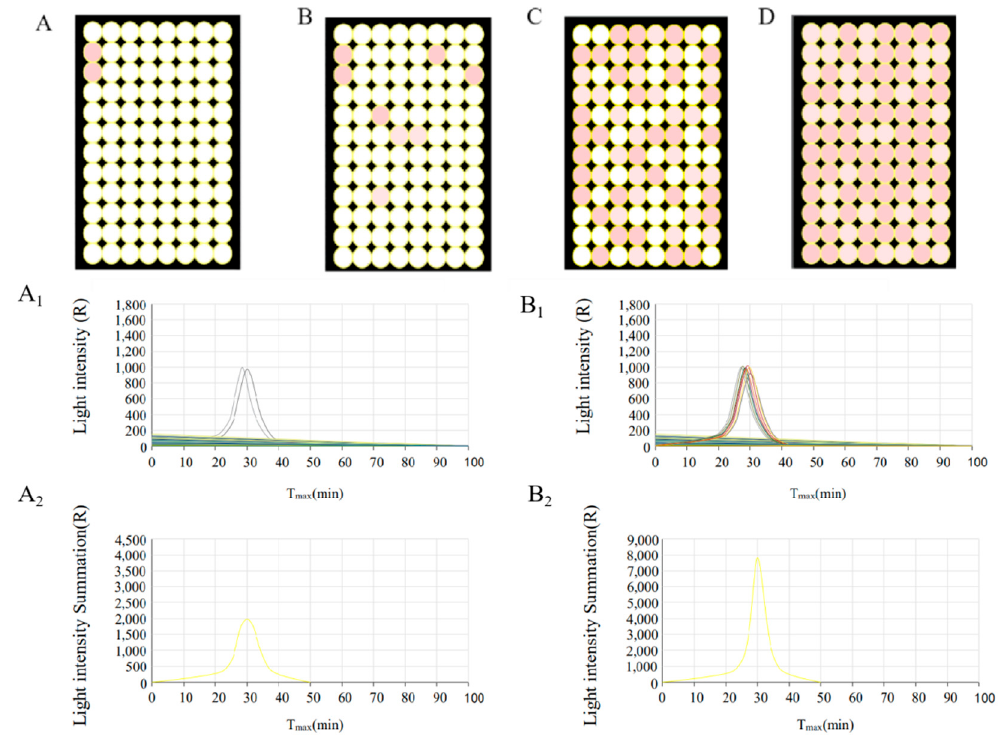
Figure 5. ( A ) RT-LAMP-BART bioluminescent well images obtained when utilizing an optimized BART reagent mixture. The target RNA template concentration for this plate was 10 copies/mL. Positive wells: 2 Negative wells: 94 Total wells: 96. ( B ) RT-LAMP-BART bioluminescent well images obtained when utilizing an optimized BART reagent mixture. The target RNA template concentration for this plate was 10 2 copies/mL. Positive wells: 8; negative wells: 88; total wells: 96. ( C ) RT-LAMP-BART bioluminescent well images obtained when utilizing an optimized BART reagent mixture. The target RNA template concentration for this plate was 10 3 copies/mL. Positive wells: 58; negative wells: 38; total wells: 96. ( D ) RT-LAMP-BART bioluminescent well images obtained when utilizing an optimized BART reagent mixture. The target RNA template concentration for this plate was 10 4 copies/mL. Positive wells: 96 Negative wells: 0 Total wells: